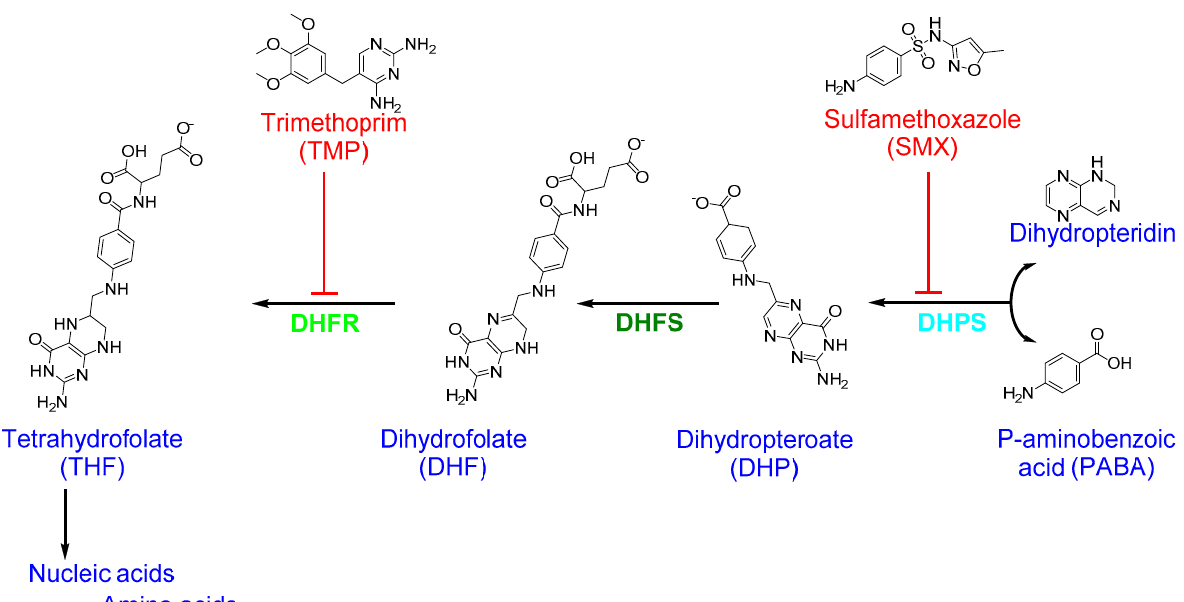
Figure 4. Folic acid biosynthesis pathway in bacteria. The key enzymes involved in folic acid metabolism are labeled in green, dark green, and turquoise while antibiotics that inhibit them are shown in red.